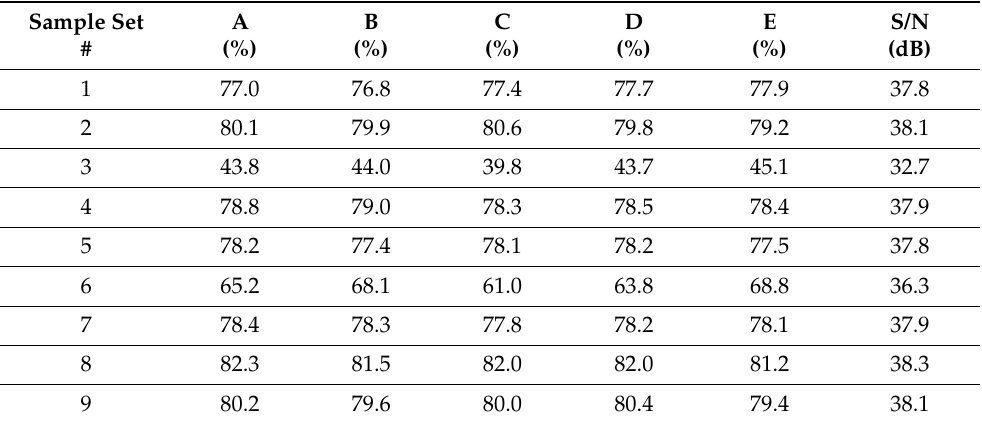
Table 7. Overall evaluation grade of the samples and their S/N ratio. Sample